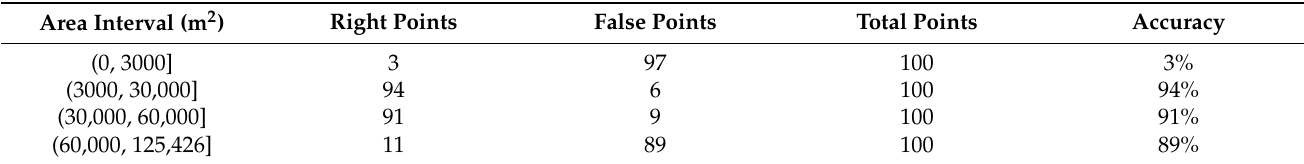
Table 2. The accuracy of shale gas well platform sample points at different area intervals. Area Interval (m 2